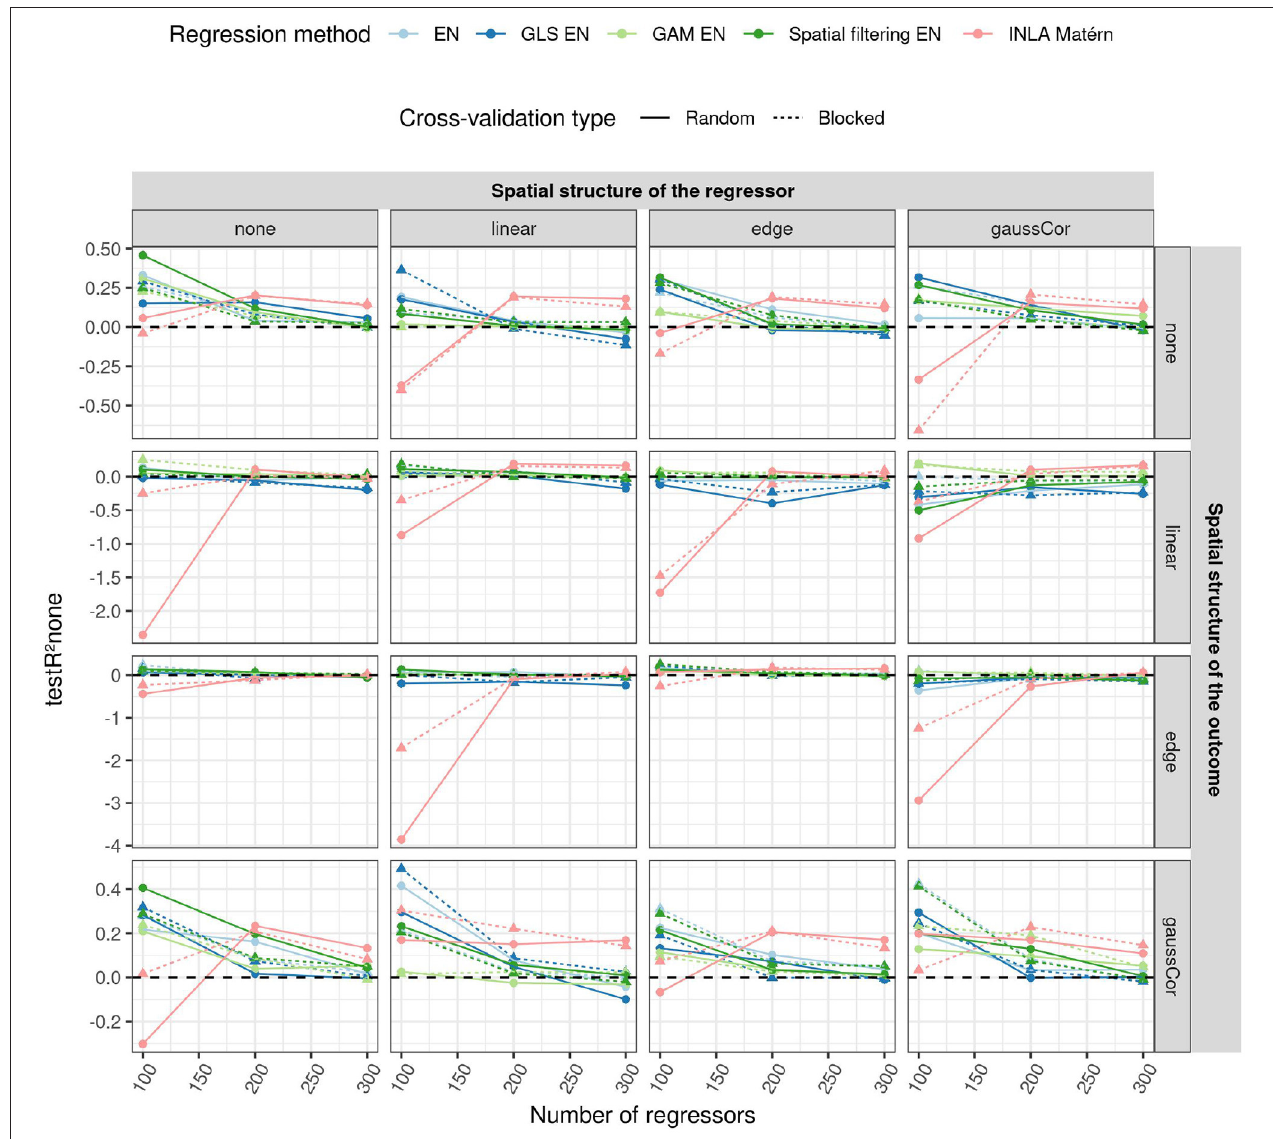
FIGURE 6 | Average R 2 on an independent test dataset without spatial structure (testR 2 none, y-axis) for the high-dimensional scenario when using different CV paradigms (shapes and linetypes) as a function of the number of regressors (x-axis), EN version (colors), the correlation structure of the regressors (columns) and of the outcome (rows). In the high-dimensional case, CV is used to tune the penalty parameter, so the model fit may depend on the CV paradigm. For this reason, test R 2 is shown for both CV paradigms in this case. The standard deviation of the non-zero components of the β parameter was 0.5. The horizontal dashed line indicates an R 2 of